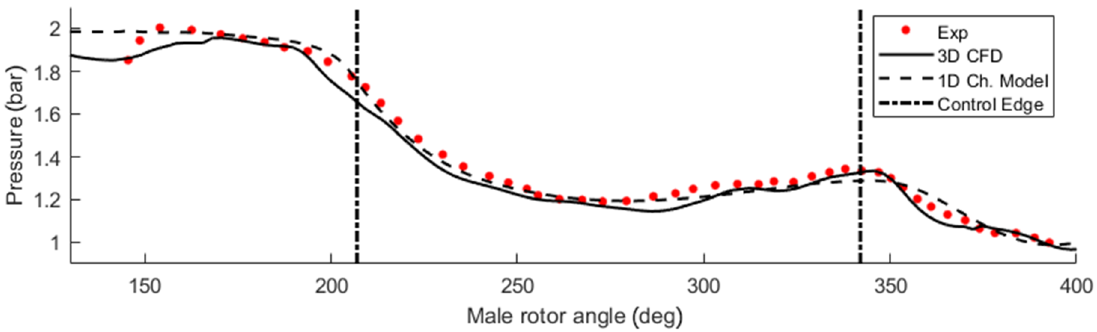
Figure 8. Validation of simulated pressure curves against male rotor’s rotational angle (n = 10,000 RPM, Pi = 2 bar and Ti = 75 °C).